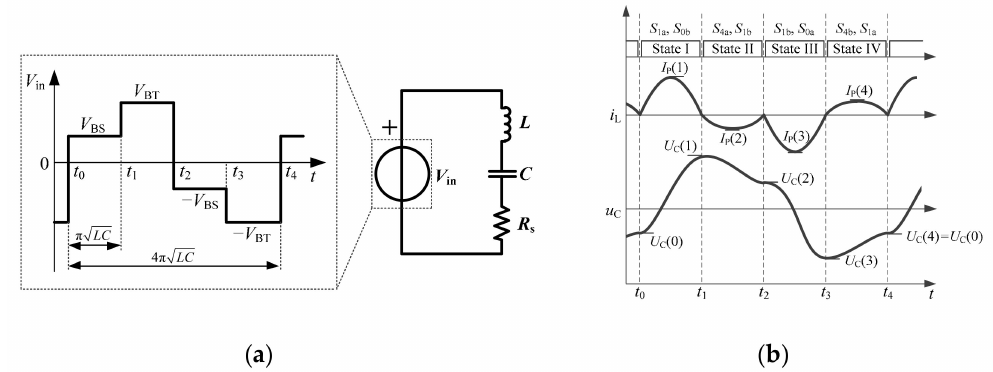
Figure 7. Theoretical waveforms of the proposed equalizer at V BT ≈ 3 V BS . ( a ) Equivalent input V in of the LC resonant tank. ( b ) Steady-state’s waveforms including driving signals, inductor current i L , and capacitor voltage u C of the